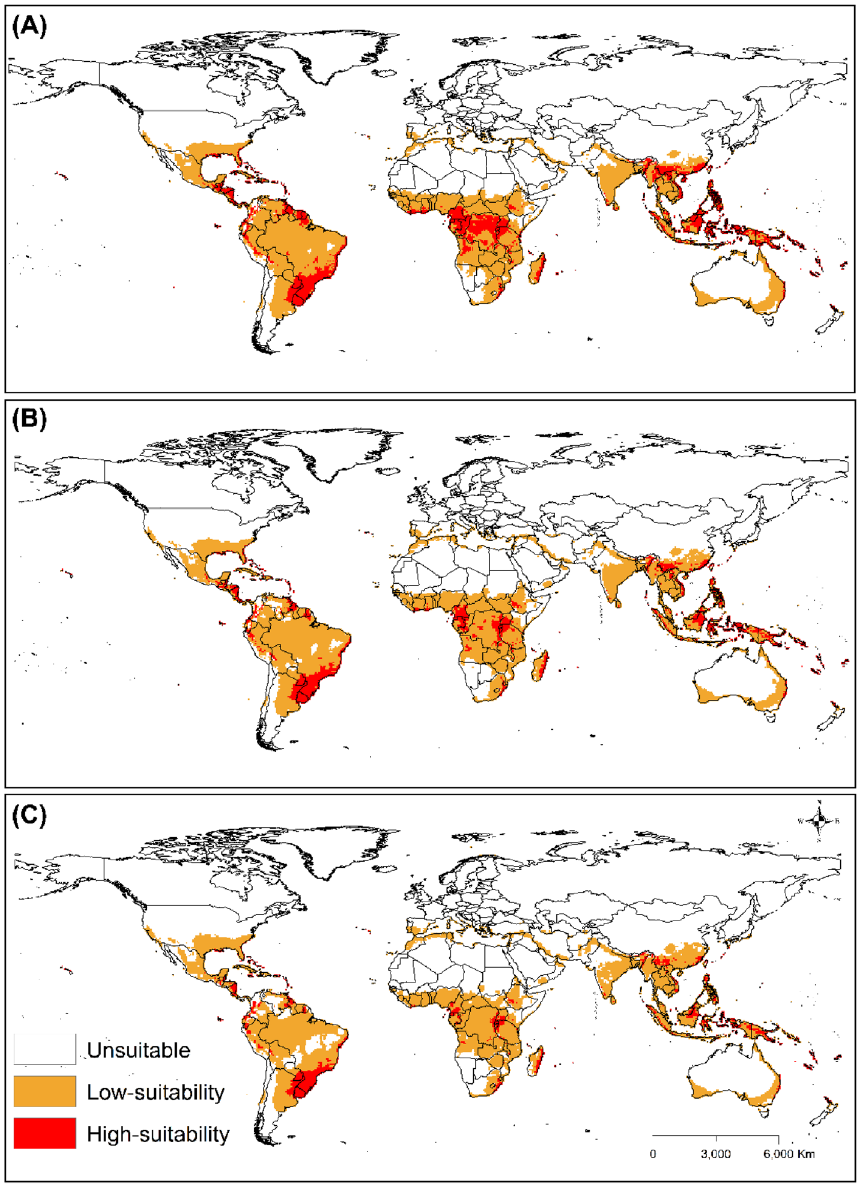
Figure 5. The Ecoclimatic Index (EI) for T. radiata modelled using the CLIMEX model in the CSIRO-Mk3.0 GCM running the SRES A1B scenario for 2050 ( A ), 2070 ( B ), and 2090 ( C ). ESRI ArcMap 10.2.2 (https:// suppo rt. esri. com/ en/ Produ cts/ Deskt op/ arcgis- deskt op/ arcmap/ 10-2- 2# downl oads) and CLIMEX 4.0.0 (https:// www. hearne. softw are/ Softw are/ CLIMEX- DYMEX/ Editi